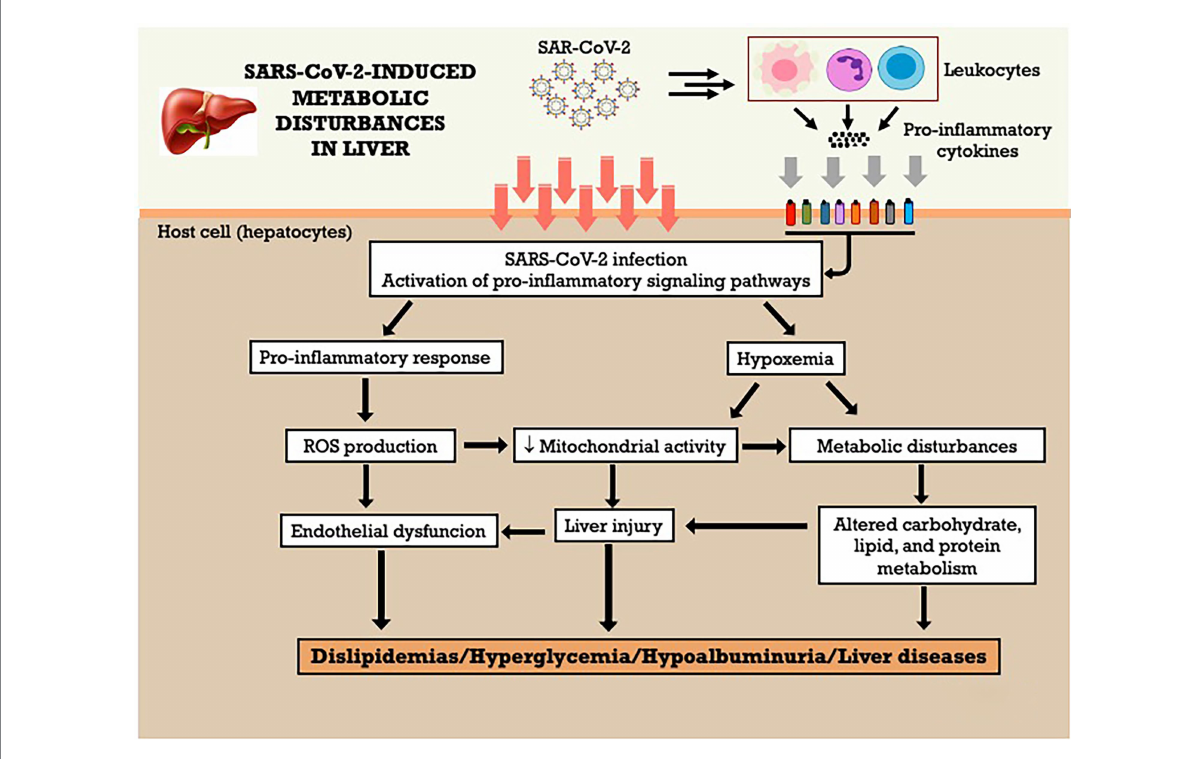
FIGURE 5 SARS-CoV-2-induced metabolic disturbances in liver. ROS, reactive oxygen